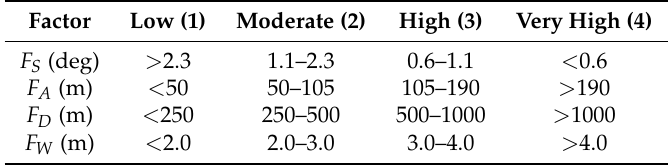
Table 1. Factors ranking needed to evaluate the Coastal Vulnerability Index